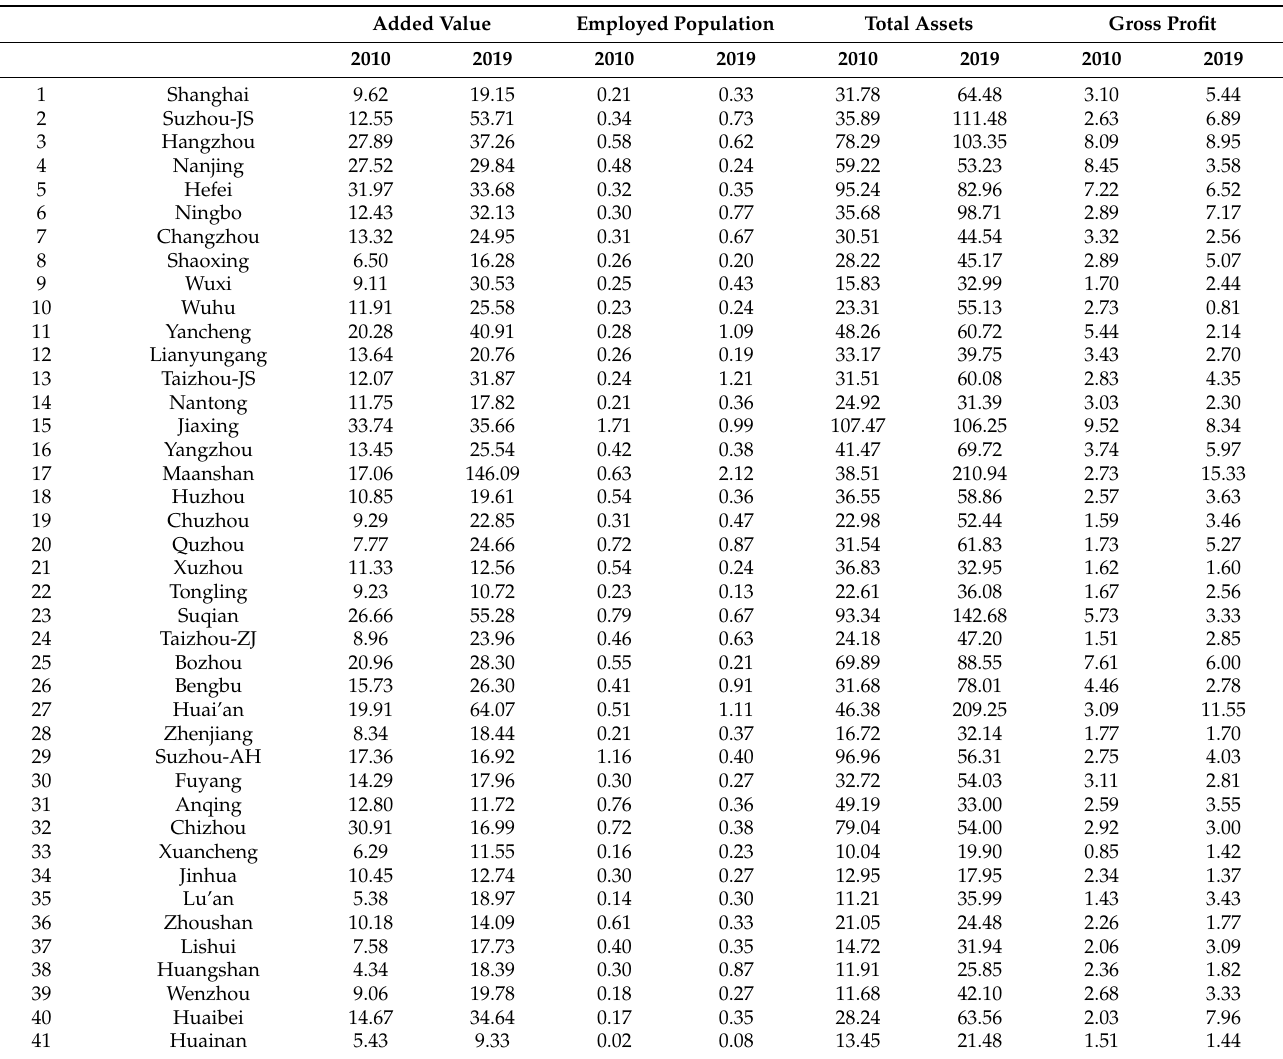
Table 2. The implications in urban industrial land consumption and manufacturing economic growth